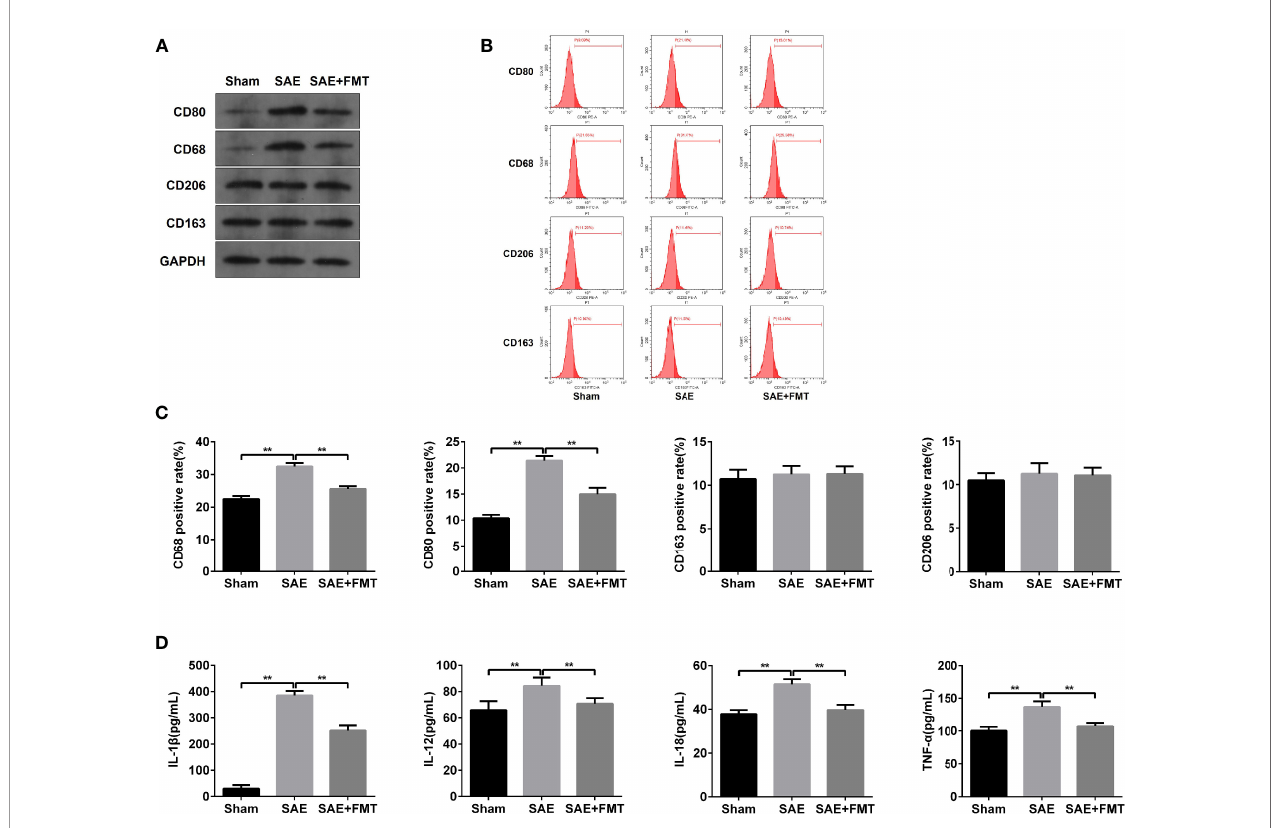
FIGURE 3 | M1 macrophage polarization detection in mesenteric lymph nodes. (A) Mesenteric lymph nodes were harvested from the Sham-operated, SAE, and FMT-challenged SAE rats. Protein expression of CD80, CD68, CD206, and CD163 as determined by WB in the mesenteric lymph nodes from different rats. (B) CD80-, CD68-, CD206-, and CD163-positive cells were measured by fl ow cytometry. (C) Quantitative analysis of the proportion of CD80-, CD68-, CD206-, and CD163-positive cells. (D) The levels of IL-1 b , IL-12, IL-18, and TNF- a were detected by ELISA kits. **P <